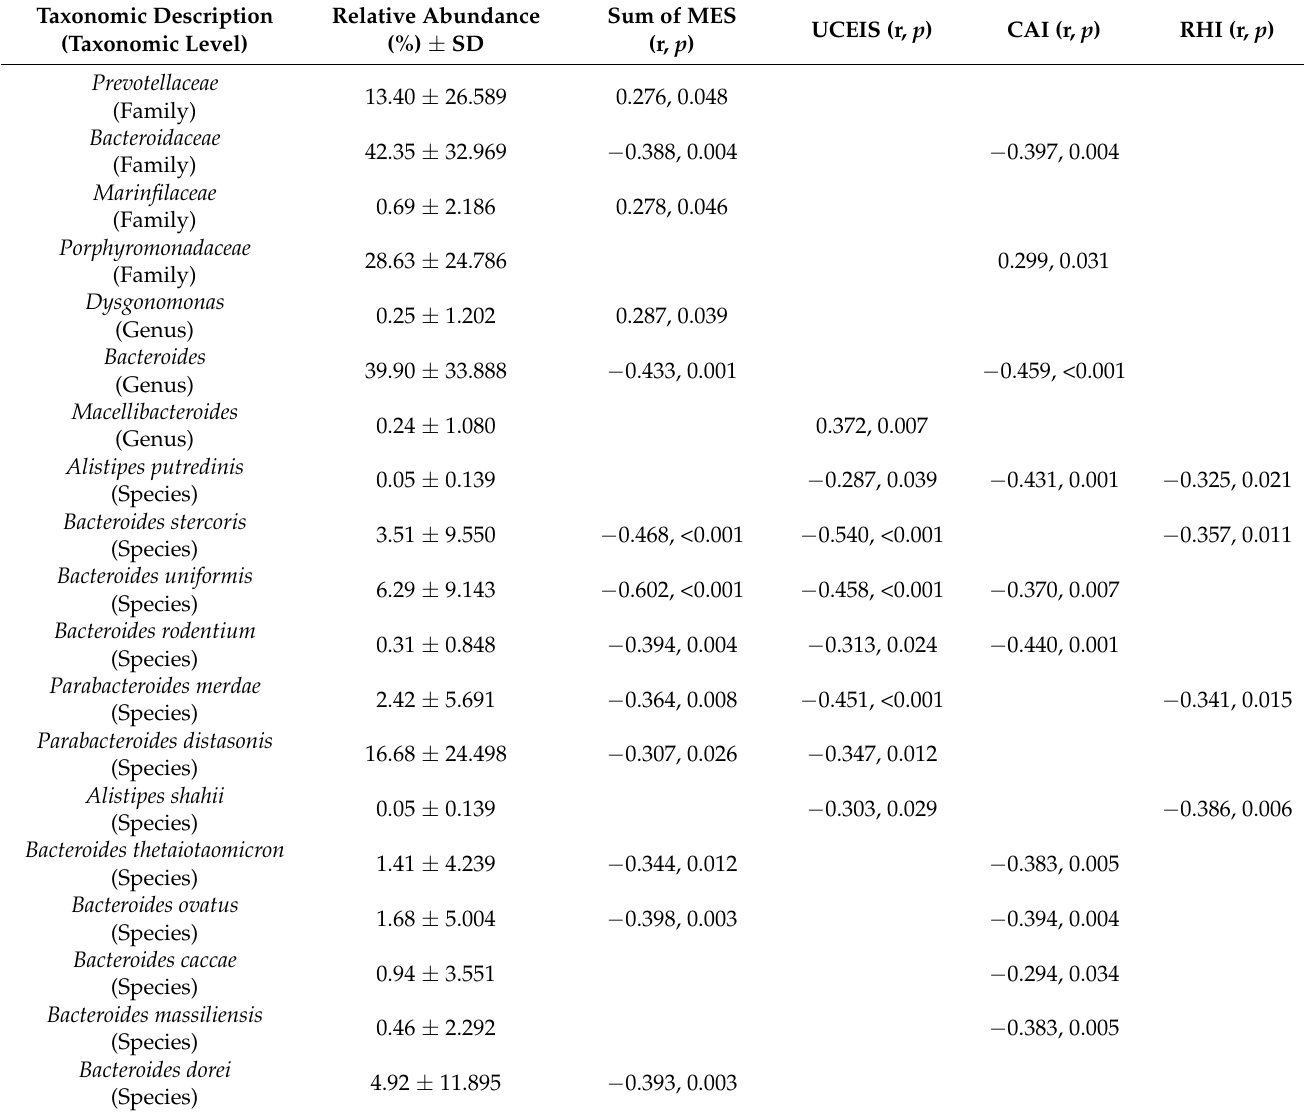
Table 3. Correlation between relative abundance of Bacteroidetes species in gut microbiota and metrics of ulcerative colitis